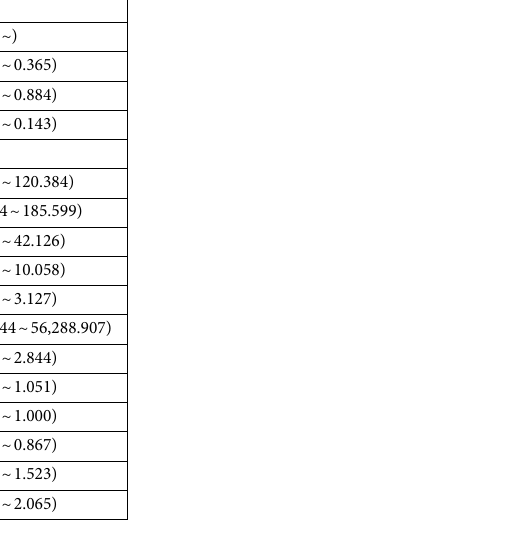
Table 4. Multivariable logistic regression